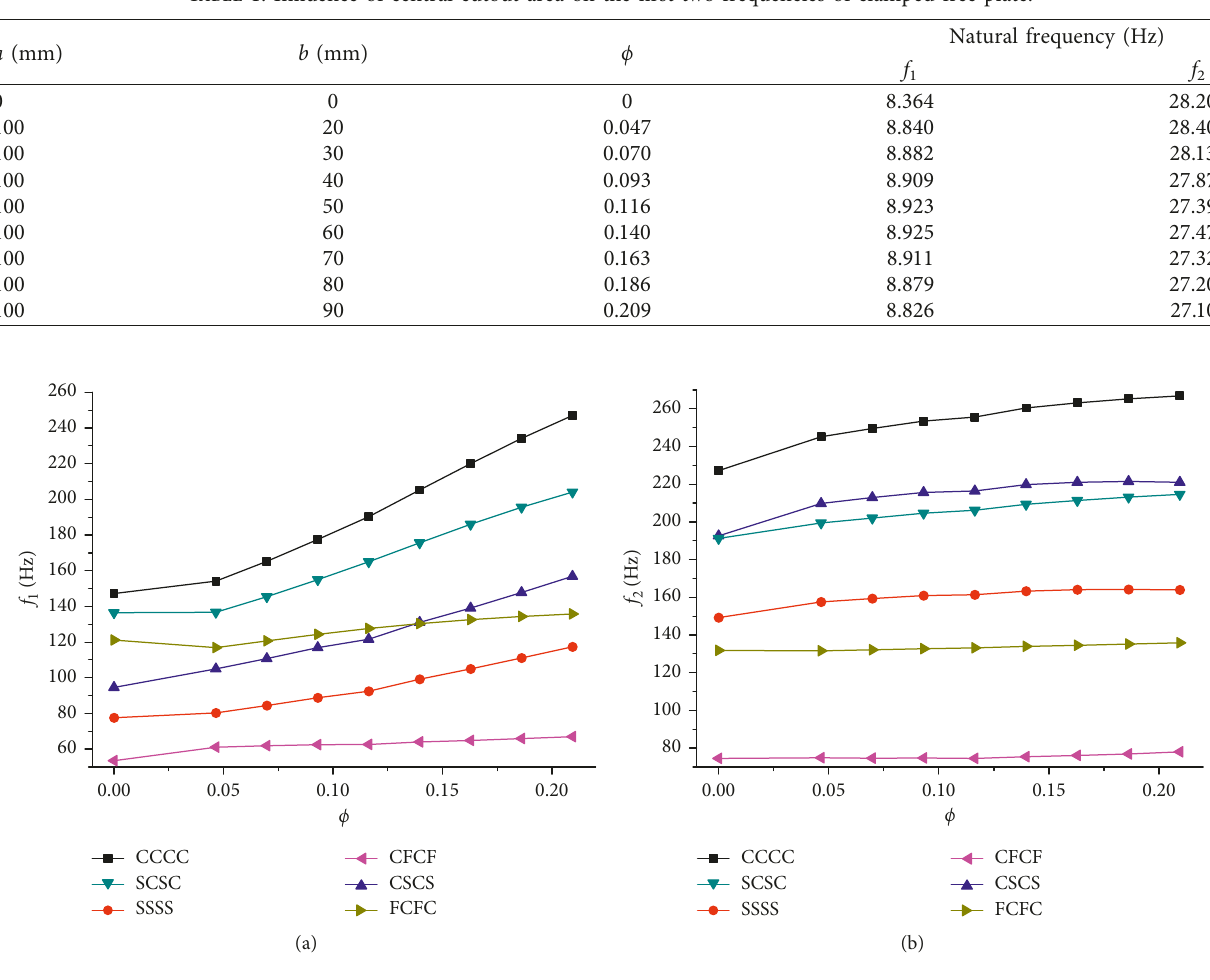
Table 1: Influence of central cutout area on the first two frequencies of clamped-free plate.